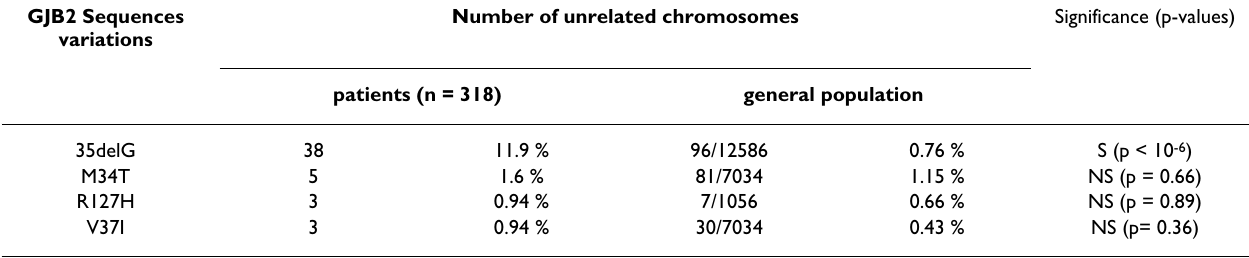
Table 5: Comparison of the allelic frequencies of GJB2 sequence variations in unrelated french patients with NSHL and in the general population GJB2 Sequences